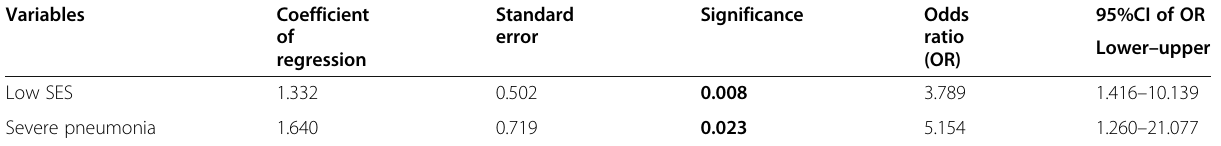
Table 4 Binary logistic regression analysis to determine the independent predictors of suboptimal vitamin D in children with